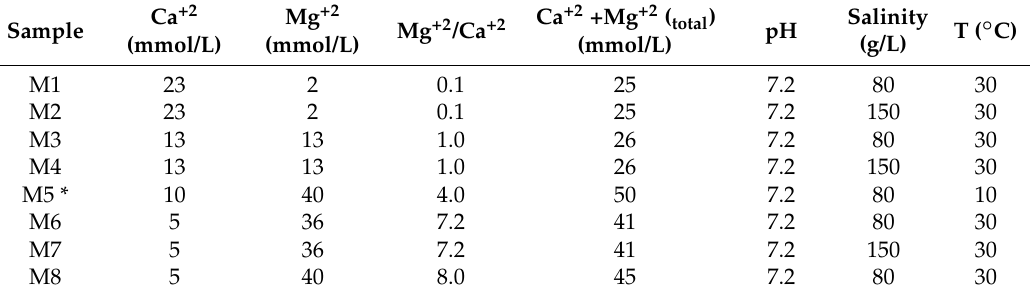
Table 2. Ionic composition of the media used in the precipitation